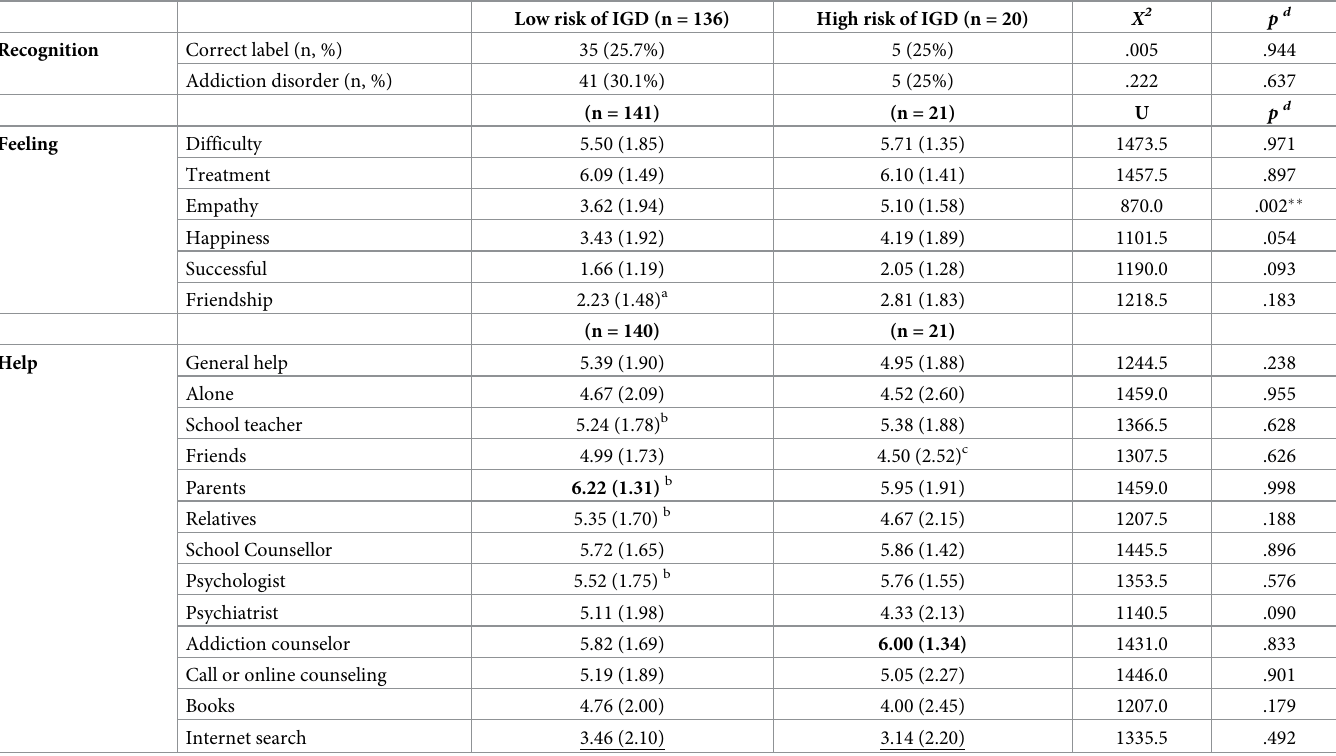
Table 4. Comparison between participants with the low and high risk of